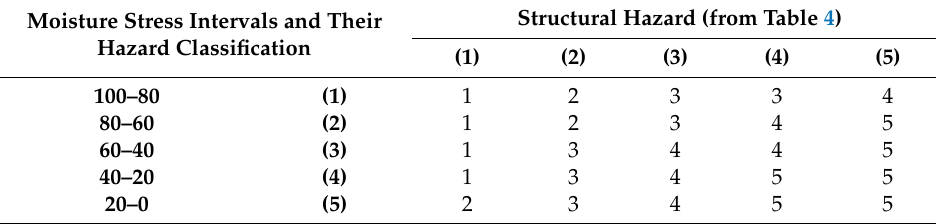
Table 5. Natural short term